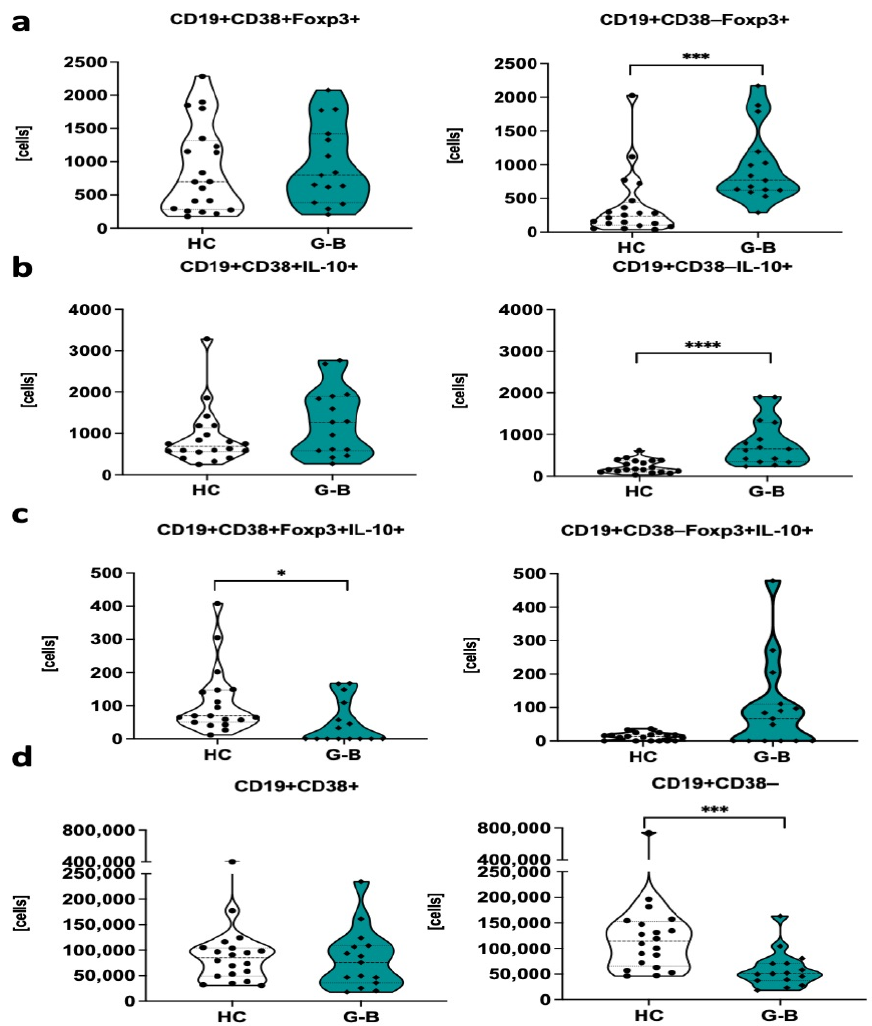
Figure 1. Differences among Graves’ disease patients and healthy control group in the context of regulatory B cell absolute numbers. Regulatory B cell subsets were distinguished based on differential CD38 marker expression and the presence of Foxp3 ( a ), IL-10 ( b ), co-expression of Foxp3, and IL-10 ( c ). Additional changes in CD38 expression within CD19+ B cells were included ( d ). Data are presented on each graph as mean with standard deviation. Significant data are indicated with as- terisks: * p < 0.05, *** p < 0.001, **** p < 0.0001.